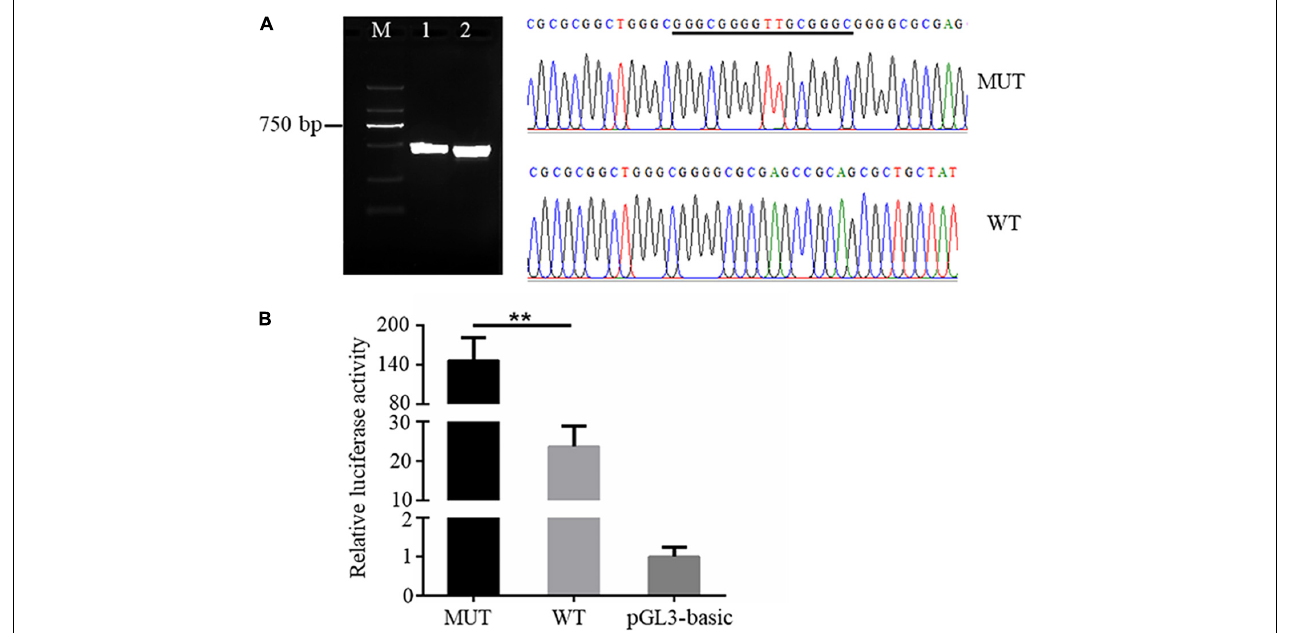
FIGURE 2 | The 16 bp insertion mutation elevates promoter transcriptional activity of the AQP3 gene. (A) Mutant and wild type sequences verified by agarose gel (left) and sequencing (right). M: DL2000 DNA ladder; 1 and 2 separately indicates the PCR products containing the insert mutation or wild type sequences. WT, wild type sequence; MUT, mutant sequence. The inserted sequences are underlined. (B) Luciferase activity of AQP3 promoter constructs containing the mutant or wild type sequences. MUT, group of cells transfected with the mutant AQP3 promoter constructs; WT, group of cells transfected with the wild type AQP3 promoter constructs; pGL3-basic, group of cells transfected with the pGL3-basic empty vector. Data depicts the mean ± SD of three independent experiments; ** P < 0.01.